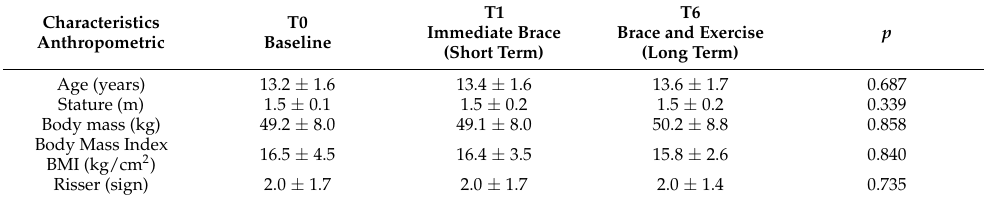
Table 4. Anthropometric and skeletal maturity profile of adolescents with idiopathic scoliosis between different timepoints: T0—baseline, T1—after immediate use of the spinal orthopedic brace (short term, 24 h), and T6—after six months of brace use associated with specific exercises (long term).